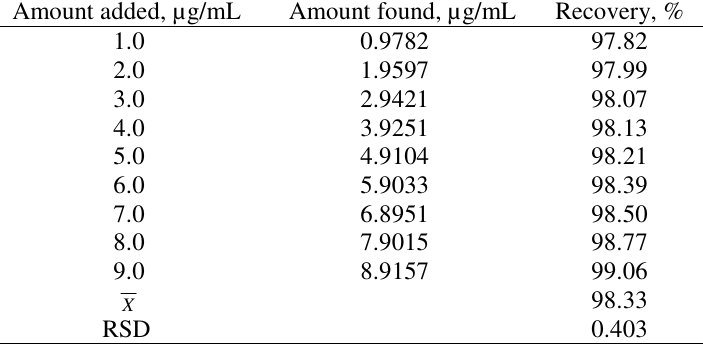
Table 5. Application of the proposed method to the determination of flucloxacillin in human urine